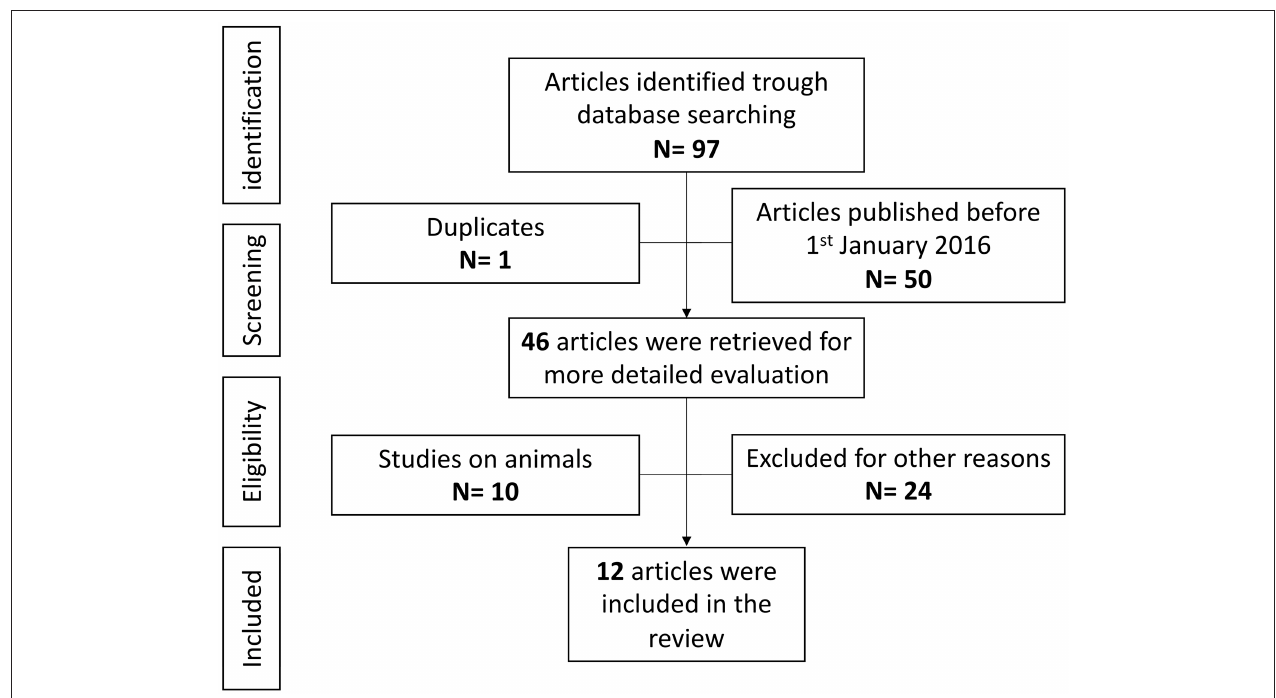
FIGURE 3 | Anti-IL-1 agents and epilepsy, literature